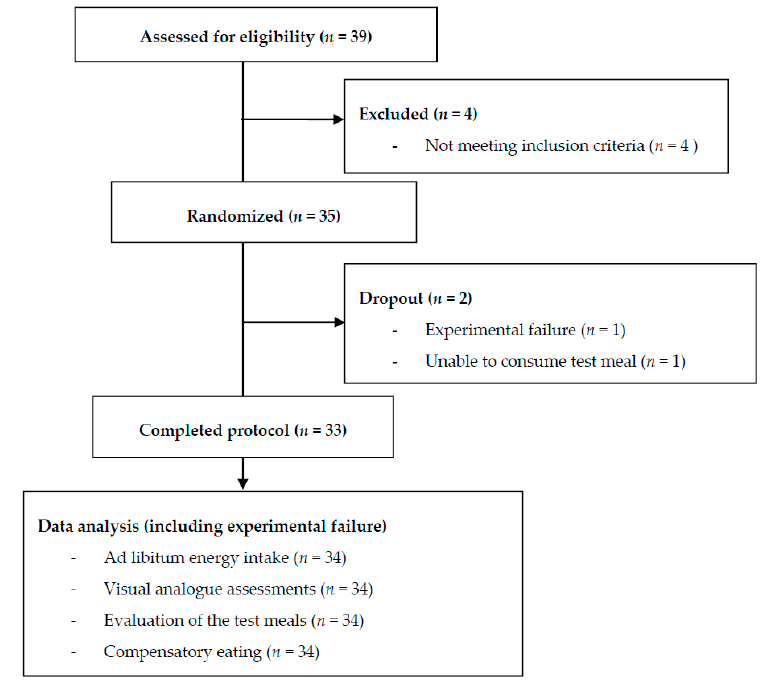
Figure 1. Participant flowchart.